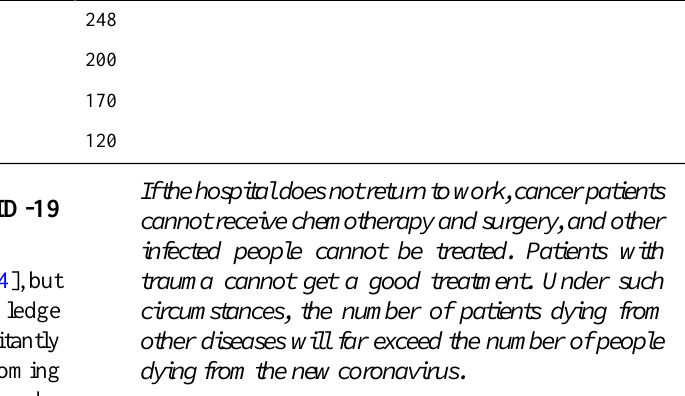
Search growth rate (%)Industry